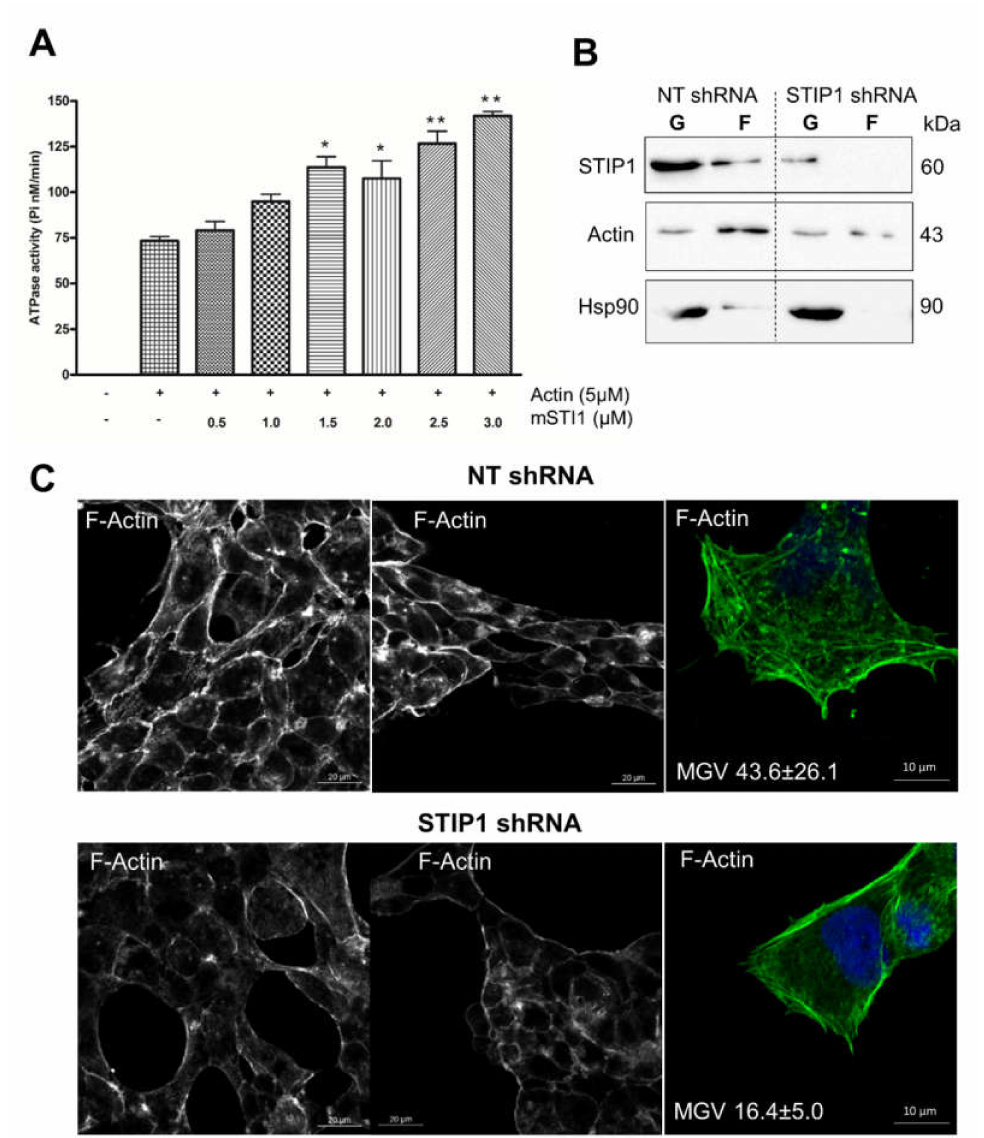
Figure 4. STIP1 regulates actin ATPase and F-actin levels ( A ) ATPase activity using increasing concentrations of mSTI1 with or without actin. Data shown have had the basal ATPase activity of the relevant concentration of mSTI1 alone subtracted. Data are representative of three